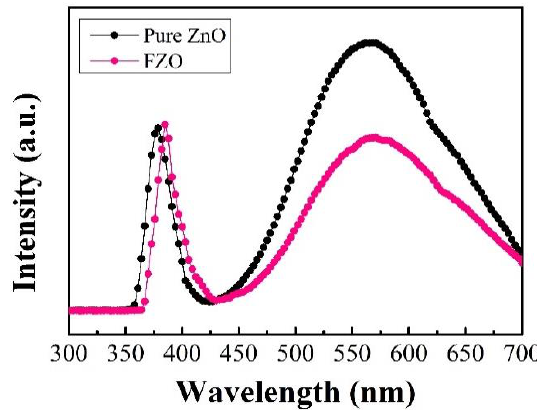
Figure 4. PL spectra of pure ZnO NRs and FZO NRs at 5 W with an excitation source of 325 nm; UV emission of FZO NRs has a red-shifted of 6 nm compared with that of pure ZnO NRs. TEM, HR-TEM, SAED, and EDX images of the synthesised FZO NRs were observed in Figure 5.